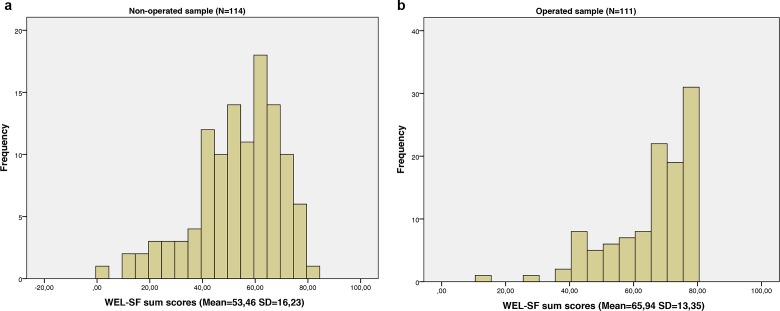
Histogram.Illustration of reported eating self-efficacy in the subsamples.